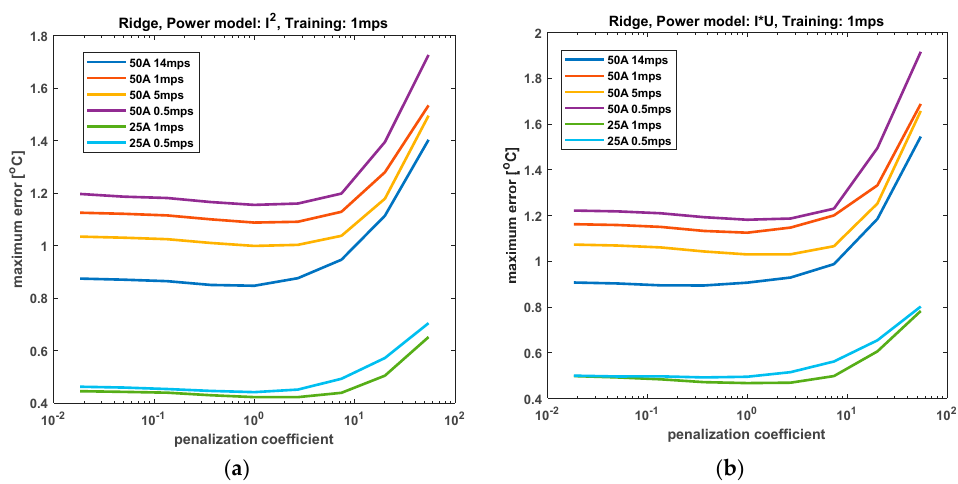
Figure 5. Maximum error vs. penalization coefficient ridge regression ( a ) I 2 power model ( b ) IU power model.